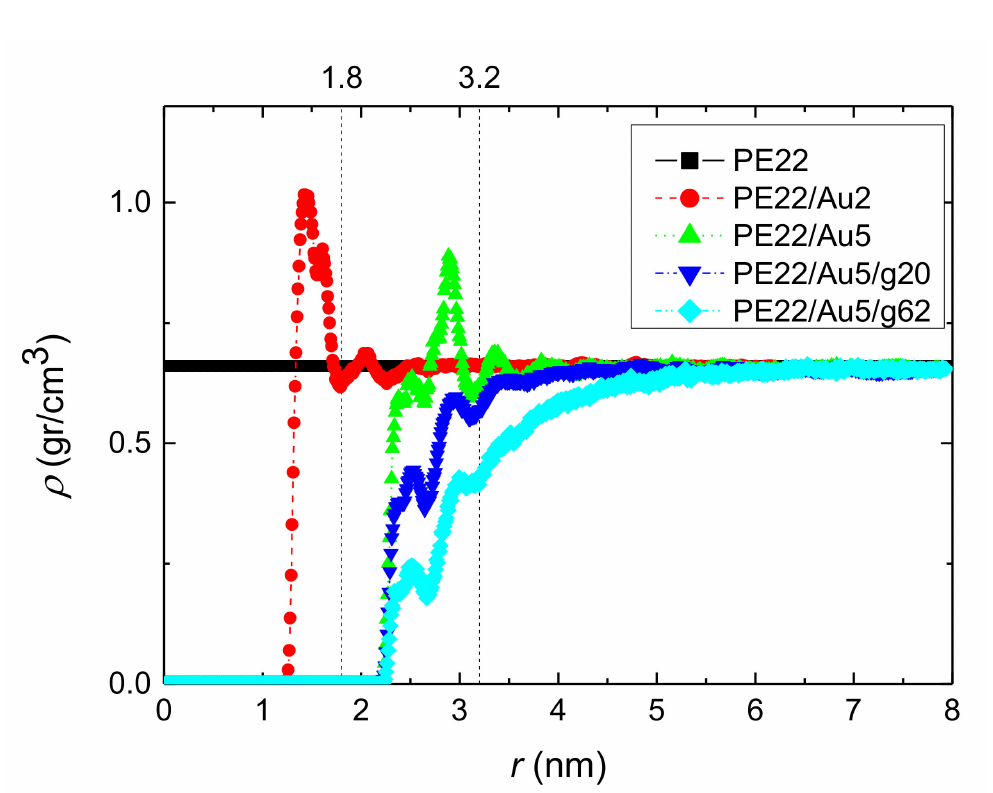
Figure A2. Mass monomer density profiles of PE chains as a function of distance from the center of the gold NP, r , for the systems: PE22, PE22/Au2, PE22/Au5, PE22/Au5/g20 and